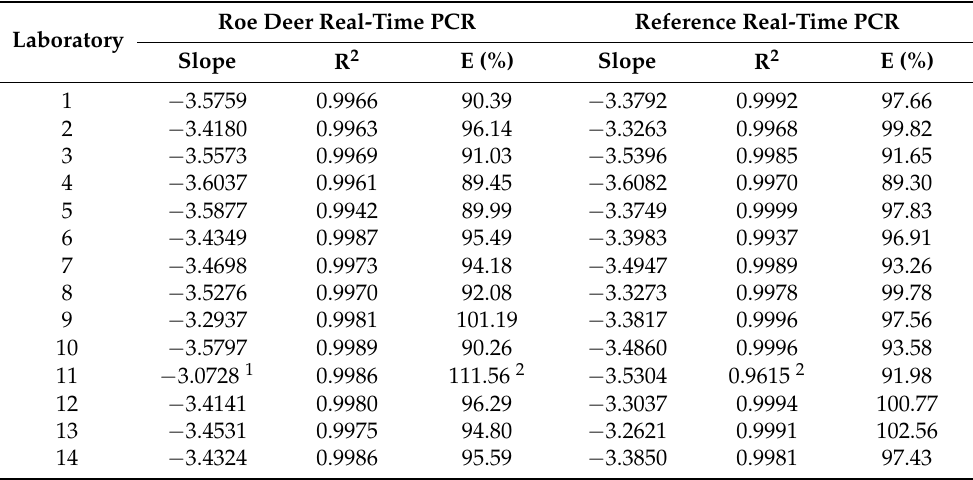
Table 3. Slope of the laboratory-specific standard curve, coefficient of determination (R 2 ), and amplification efficiency (E) for the roe deer real-time PCR assay and the reference real-time PCR assay. Roe Deer Real-Time Laboratory